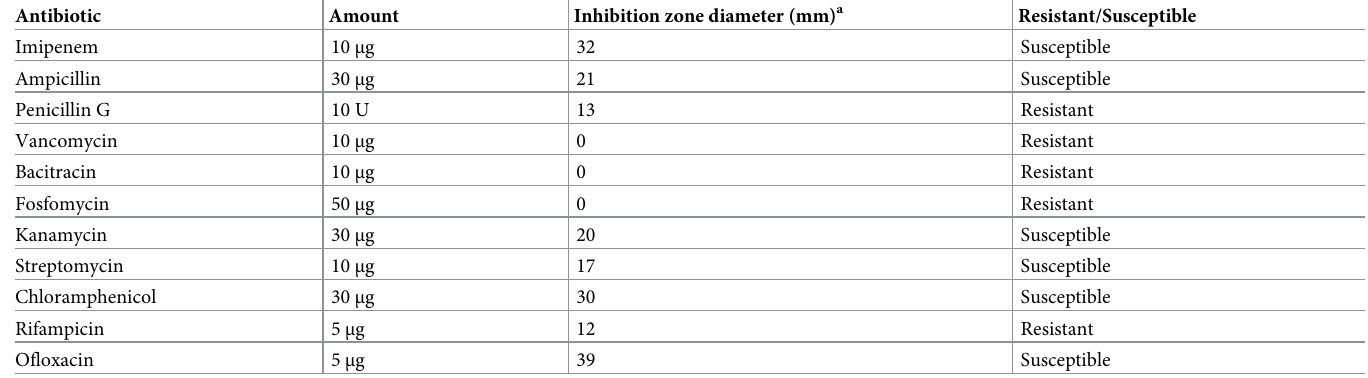
Table 1. Antibiotic susceptibility profile of P . agglomerans KM1.